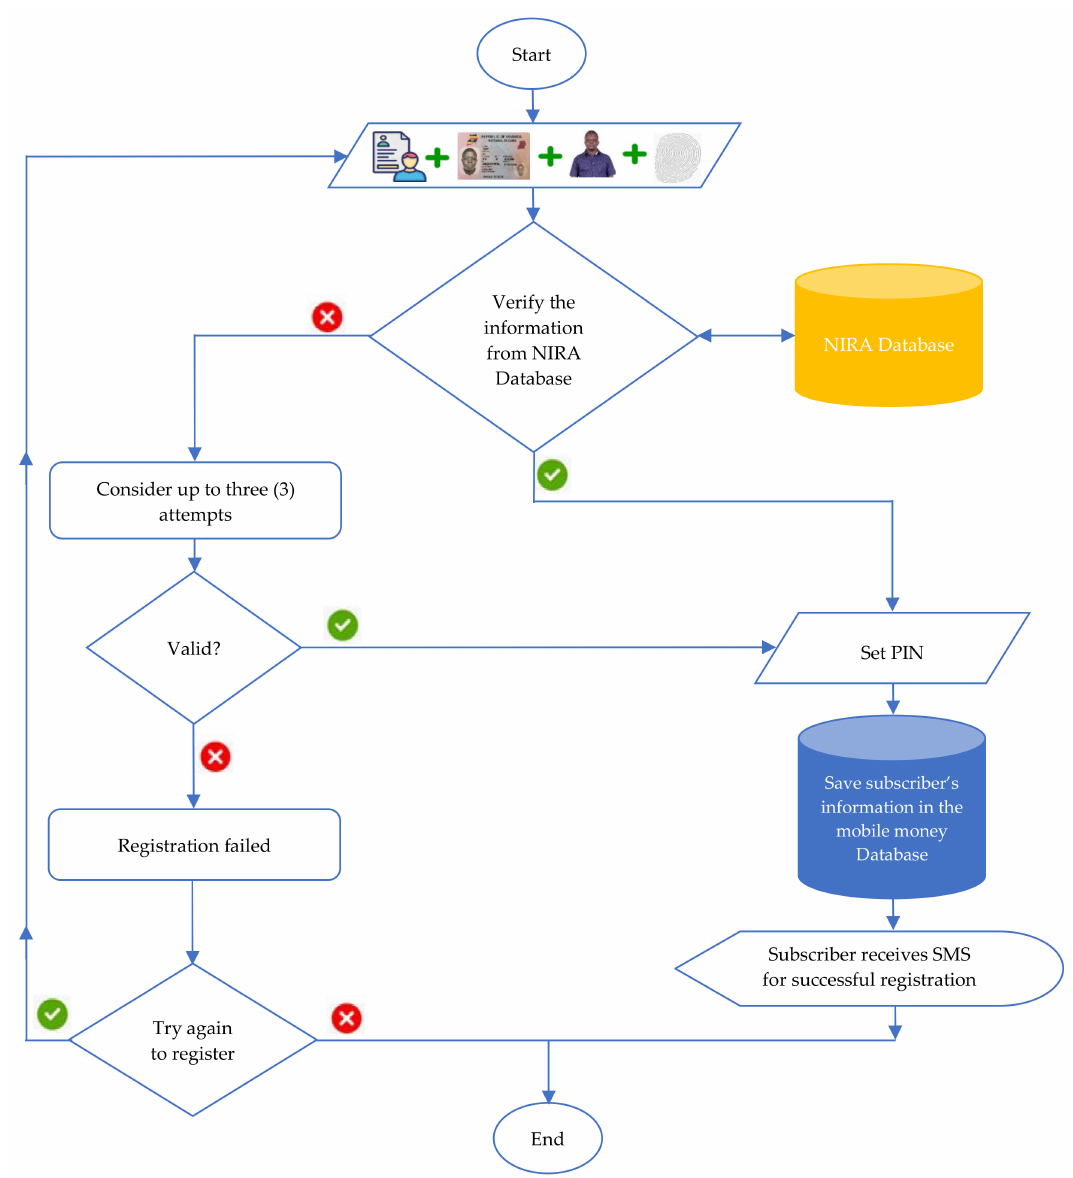
Figure 2. Mobile money enrolment